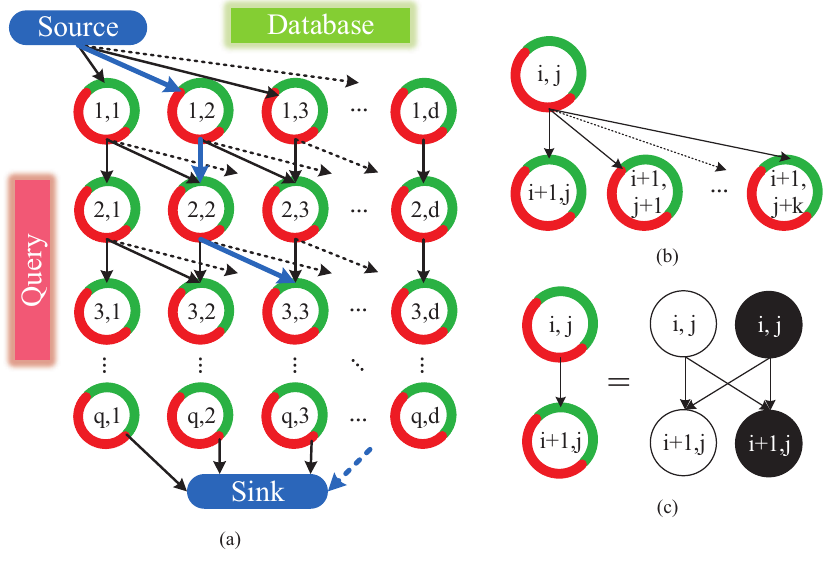
Figure 12. The global optimization model of Visual Localizer: ( a ) data association graph is comprised of “nodes” and directed arcs which are derived from database and query descriptors; ( b ) the arcs connect a “node” ( i , j ) with k + 1 adjacent “nodes” ( i + 1, j + s ) , where 0 ≤ s ≤ k and j + s ≤ d ; and ( c ) a “node” in graph involves a matching node (white node) and a hidden node (black node), while the arc interconnecting “nodes” is composed of edges interconnecting with matching and hidden